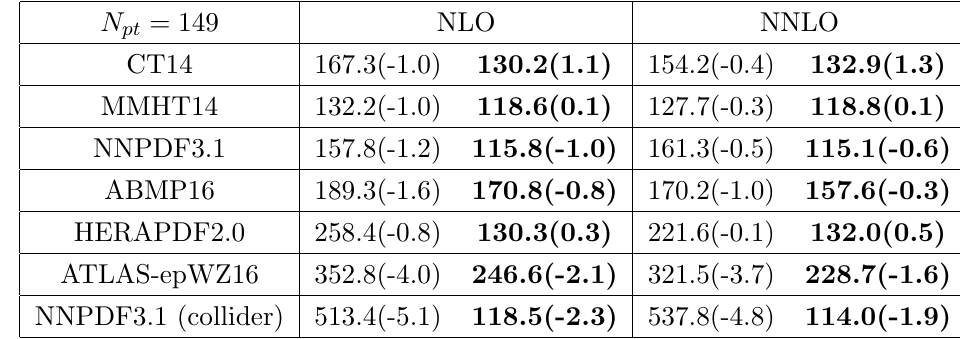
(cid:31) 2 and normalization shift (in unit of 1 (cid:27) error) of (cid:12)ts to NuTeV and CCFR charm production data with various theoretical predictions using m shifts are shown in brackets with minus sign indicating the data prefer smaller values for the cross sections. The numbers in bold font correspond to (cid:12)ts including the full PDF uncertainties as well.